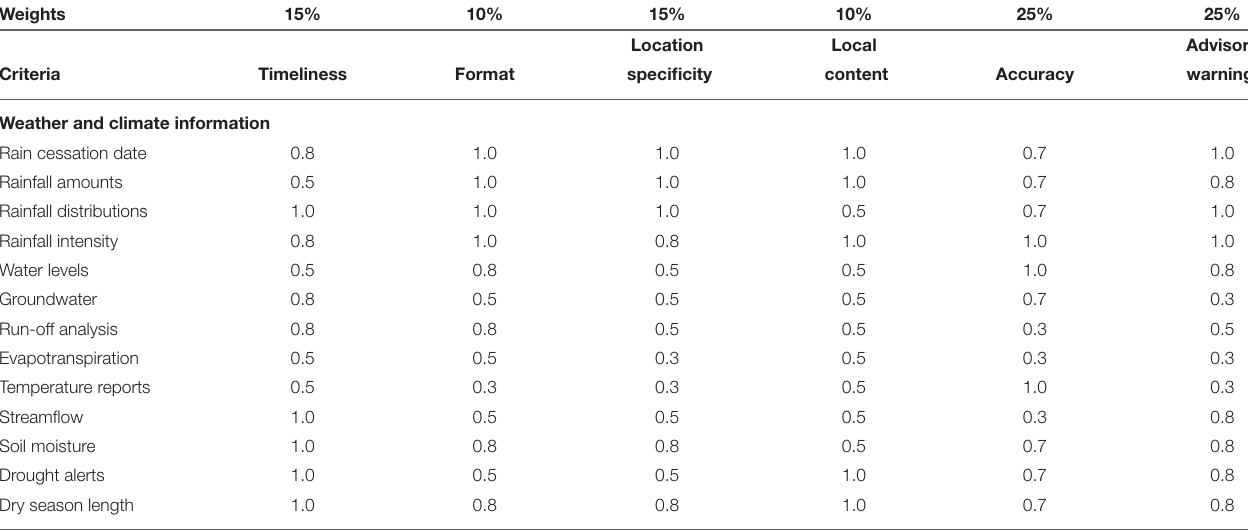
TABLE 9 | Estimates of normalized decision matrix a in water resources and relative significances of criteria (criteria weights) (Water